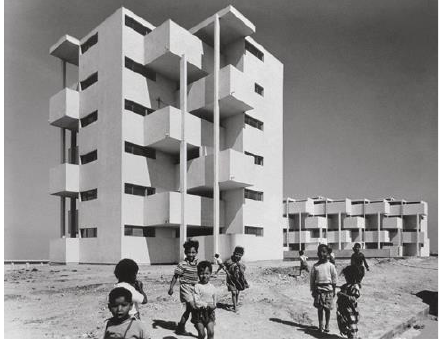
Figure 4 André Studer & Jean Hentsch, Sidi Othman Apartment Buildings , Casablanca, in 2008, (Url